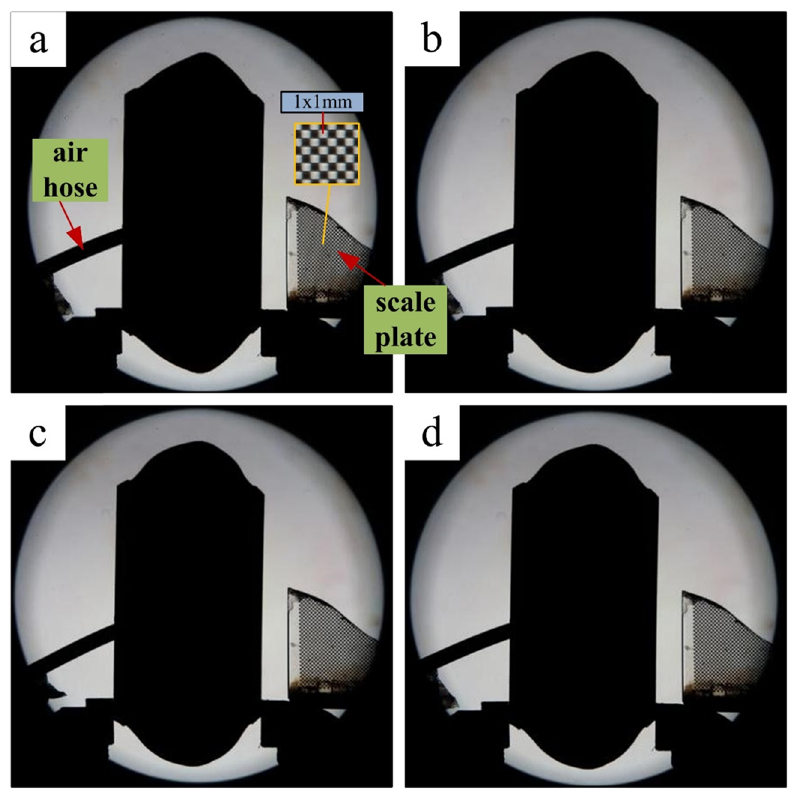
Figure 15: Schlieren photograph of centerbody. ( a ) Initial pro fi le; ( b ) 0.2 MPa bump pro fi le; ( c ) 0.4 MPa bump pro fi le; ( d ) 0.6 MPa bump pro fi